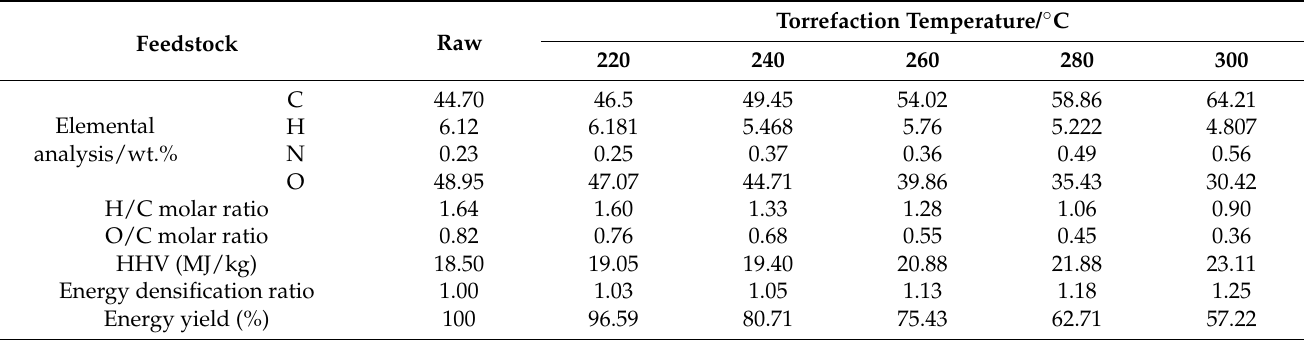
Table 1. The elemental analysis, heating value, and energy yield of raw and torrefied corn cobs.